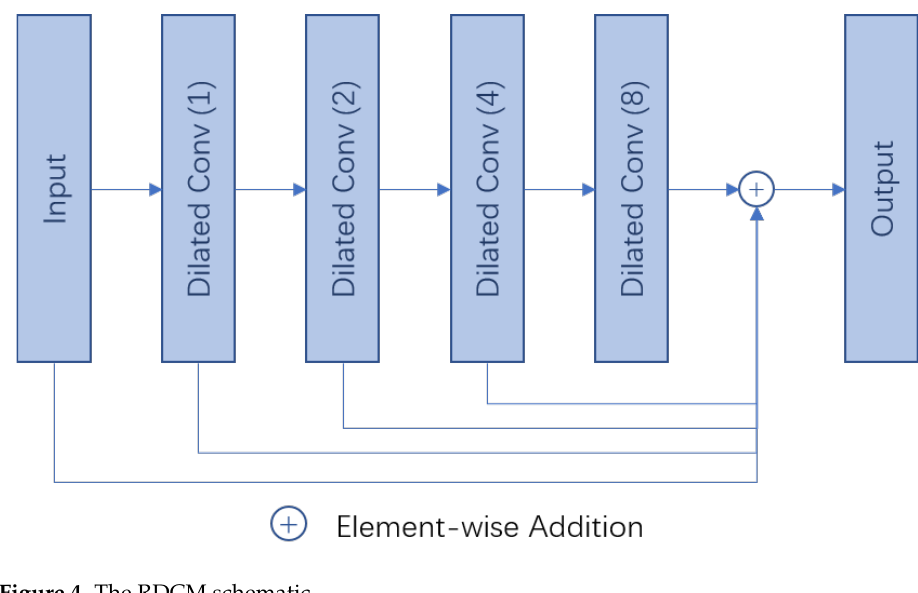
Figure 4. The RDCM